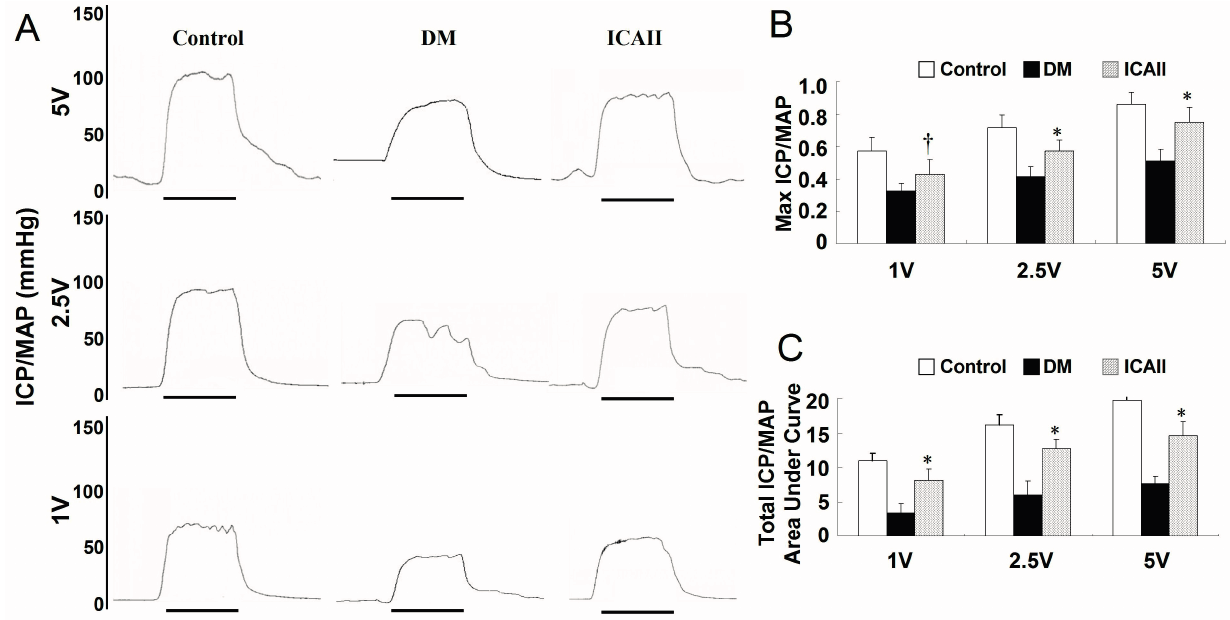
Figure 1. ICA II enhances erectile function in diabetic rats. ( A ) Representative intracavernous pressure (ICP) responses to electrical stimulation of the cavernous nerve for age-matched normal control and diabetic groups. The stimulus interval (60 s) is indicated by a solid bar; ( B , C ) Erectile function presented as maximal ICP/MAP and total ICP/MAP (AUC/MAP) in each group. * p < 0.01, † p < 0.05 in the ICA II-treated group compared with the DM placebo